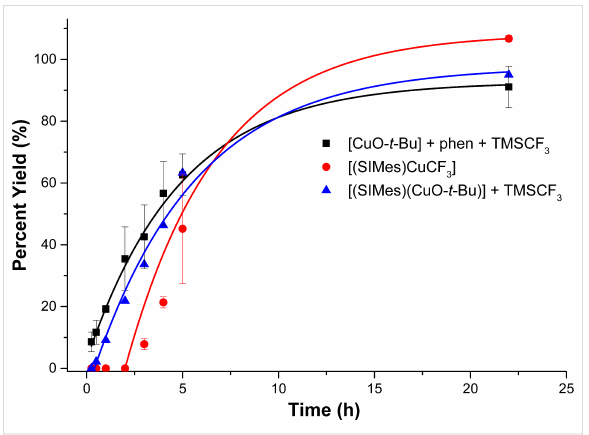
Figure 4: Reaction of 2-iodotoluene with systems A1 , A2 , and B2 to produce 1-methyl-2-(trifluoromethyl)benzene. Conditions for B2 : DMF, 50 °C. Conditions for A1 and A2 : DMI/benzene (1.5:7.5), 50 °C. Yields were calculated by 19 F NMR spectroscopy versus an internal